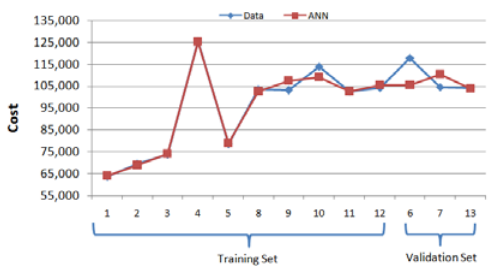
Fig. 2. Plot of the masked cost versus the prediction using NN